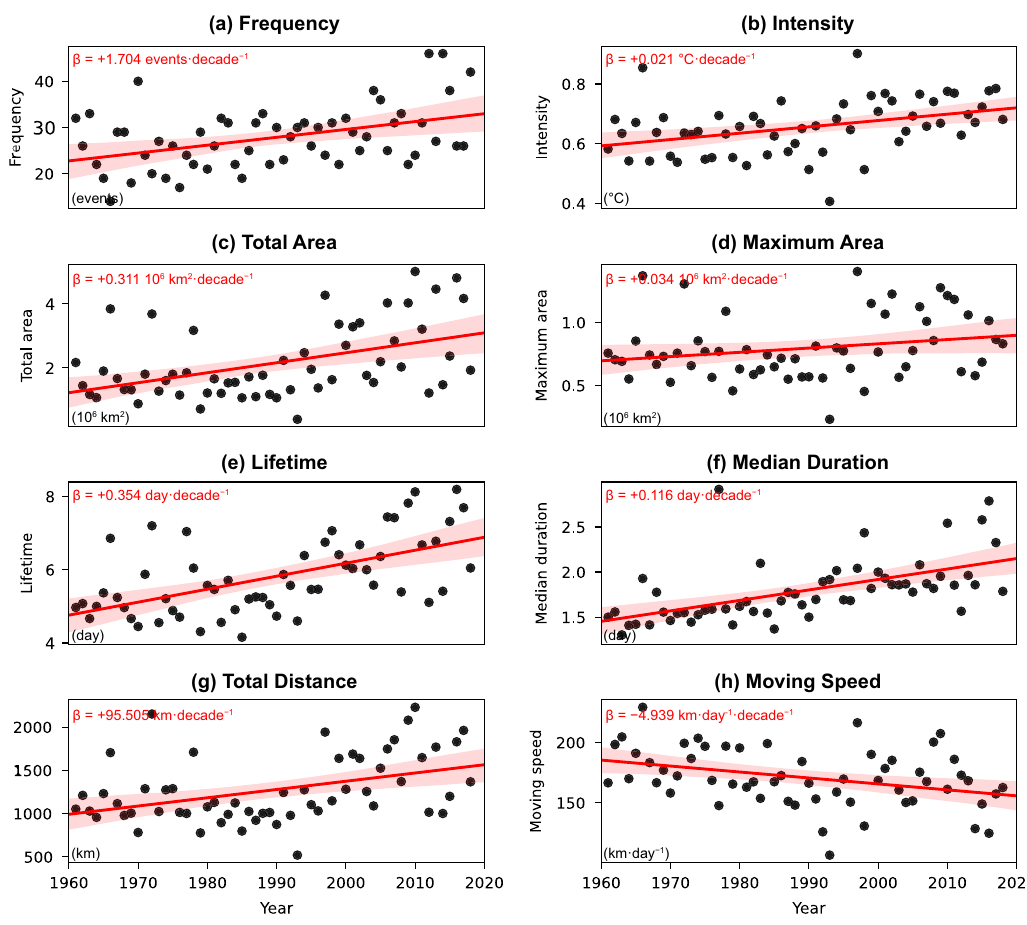
Fig. 2 Time series of the yearly statistics of the contiguous heatwaves metrics across China during 1961 – 2018. a Time series of the yearly frequency of the contiguous heatwave. b – h As ( a ) but for intensity, total area, maximum area, lifetime, median duration, total moving distance, and moving speed, respectively. The red straight line indicates the corresponding linear trend, with the red text indicating the trend magnitude. The pink shading indicates the 95% con fi dence interval of the fi tted line. All trends are statistically signi fi cant at the 0.05